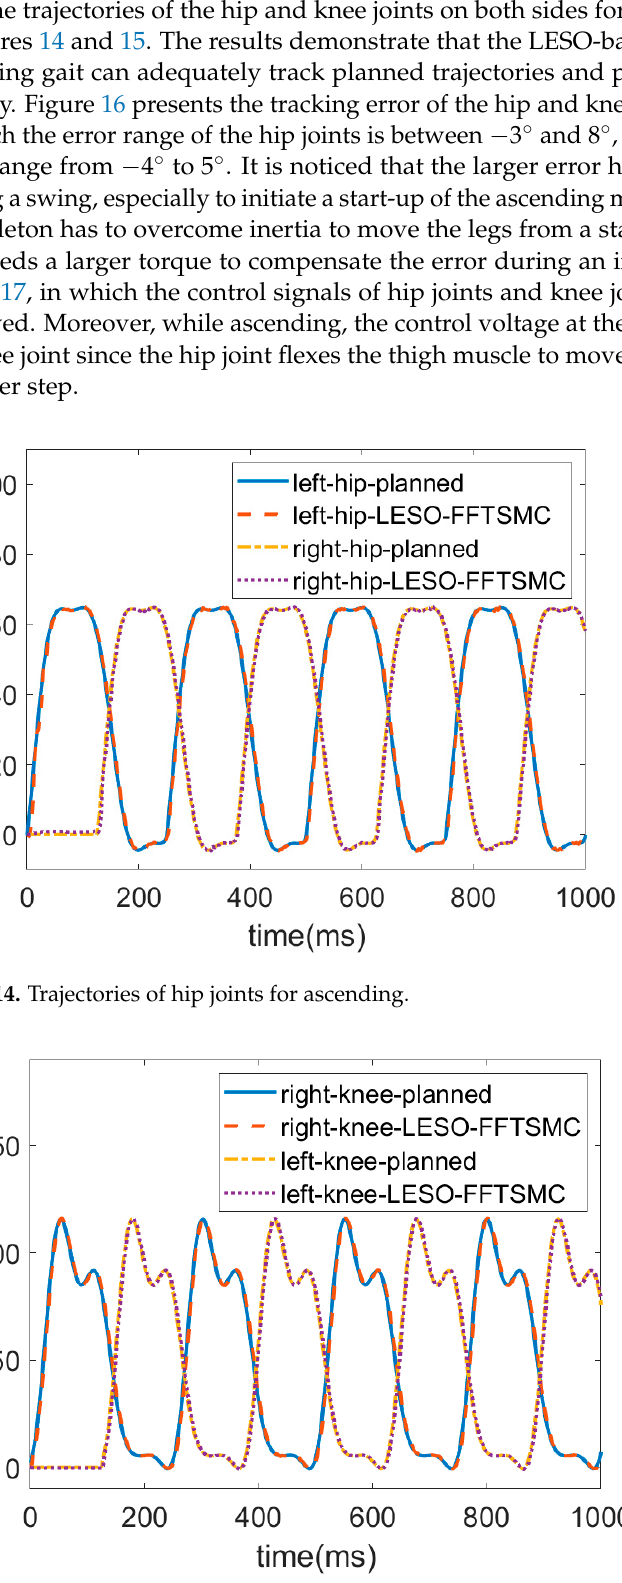
Figure 15. Trajectories of knee joints for ascending.